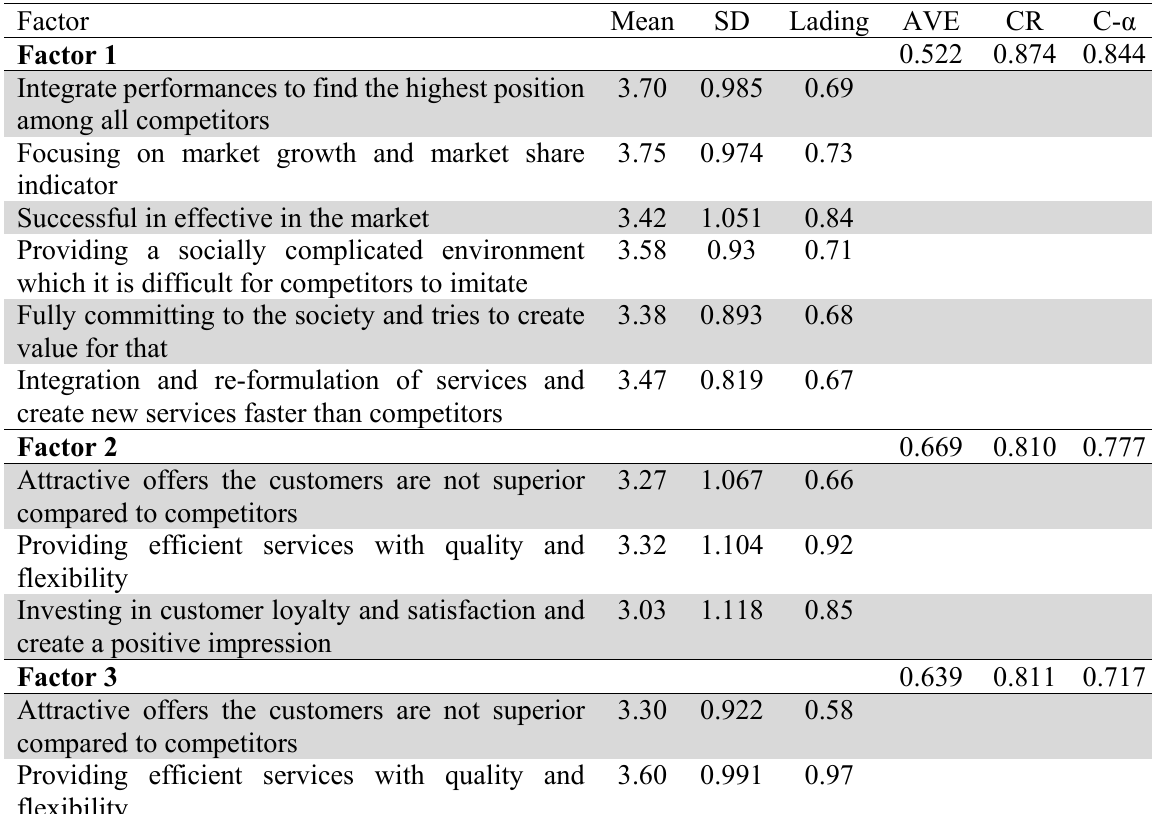
Results of CFA and internal reliability testing & K–M–O measure Factor Mean SD